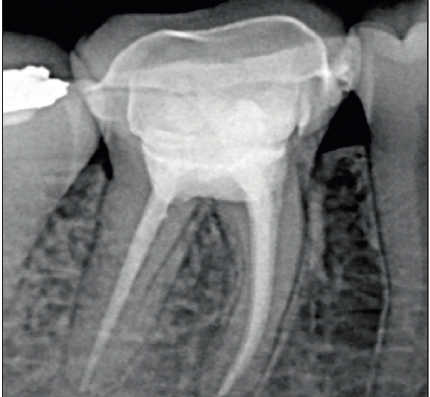
Figure 9: Tissue surface of pressed endocrown.